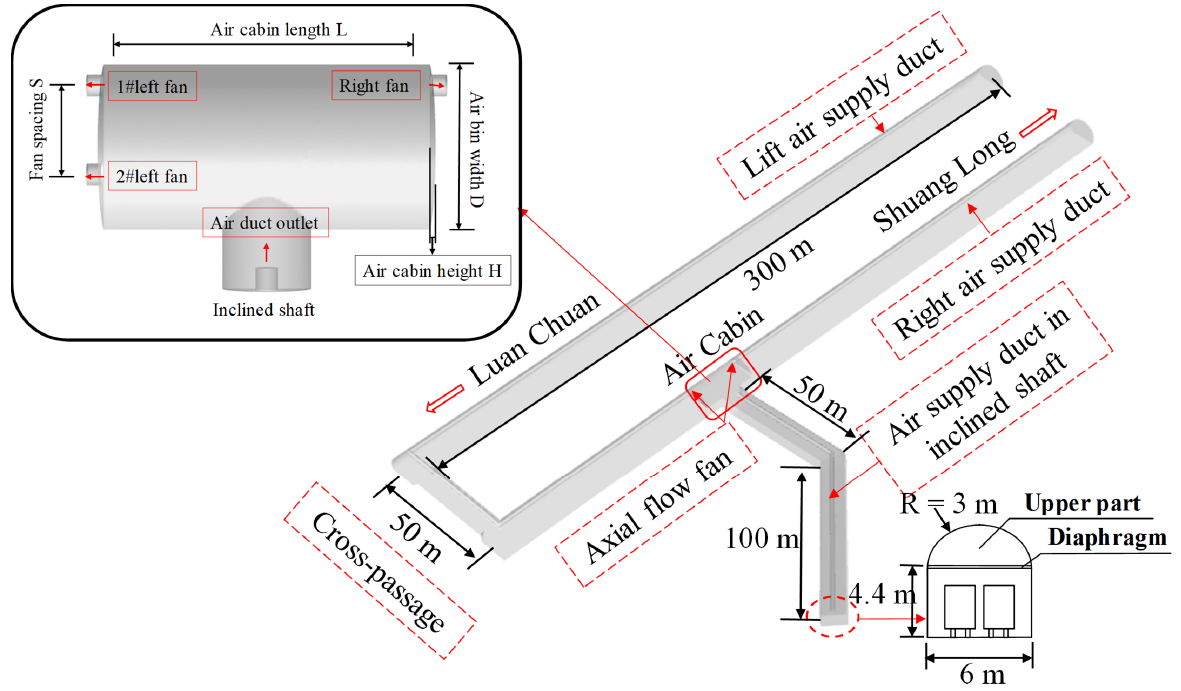
Figure 4. Schematic of the physical model.